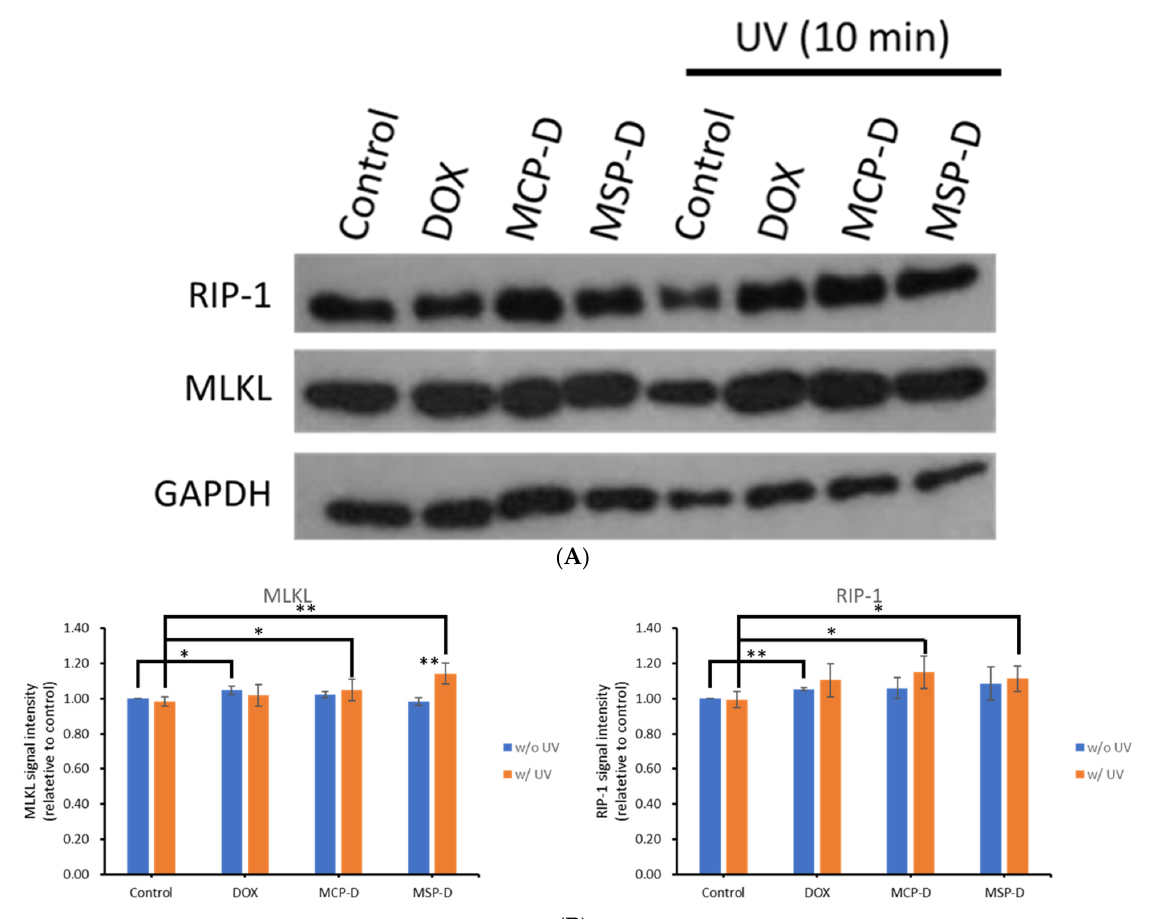
Figure 7. Expression levels of necroptosis-related proteins of HT1080 cells exposed to free doxorubicin (DOX) and DOX-loaded MCP (MCP-D) and DOX-loaded MSP (MSP-D) at an equivalent DOX concentration of 1 µg/mL for 4 h with and without UV light irradiation for 10 min ( A ). Cell lysates were extracted and protein expression was detected using Western blot. GAPDH was used as internal control for equal loading. Quantitative evaluation of MLKL and PIP-1 proteins expression was relative to control group ( B ) (* p < 0.05, ** p < 0.005).